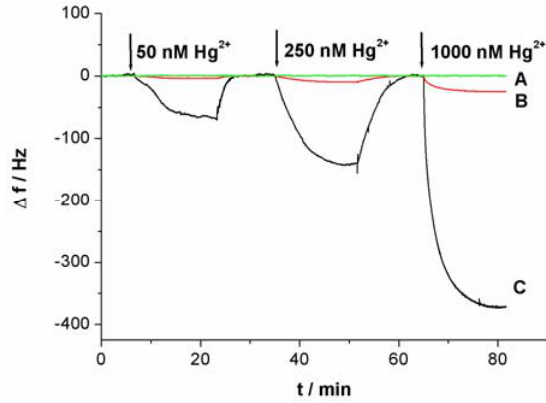
Figure 3. Signal responses of the QCM-based sensor to Hg 2+ in different linking probe solution. ( A ) Tris-HCl buffer without linking probe; ( B ) linking probe 1; ( C ) linking probe